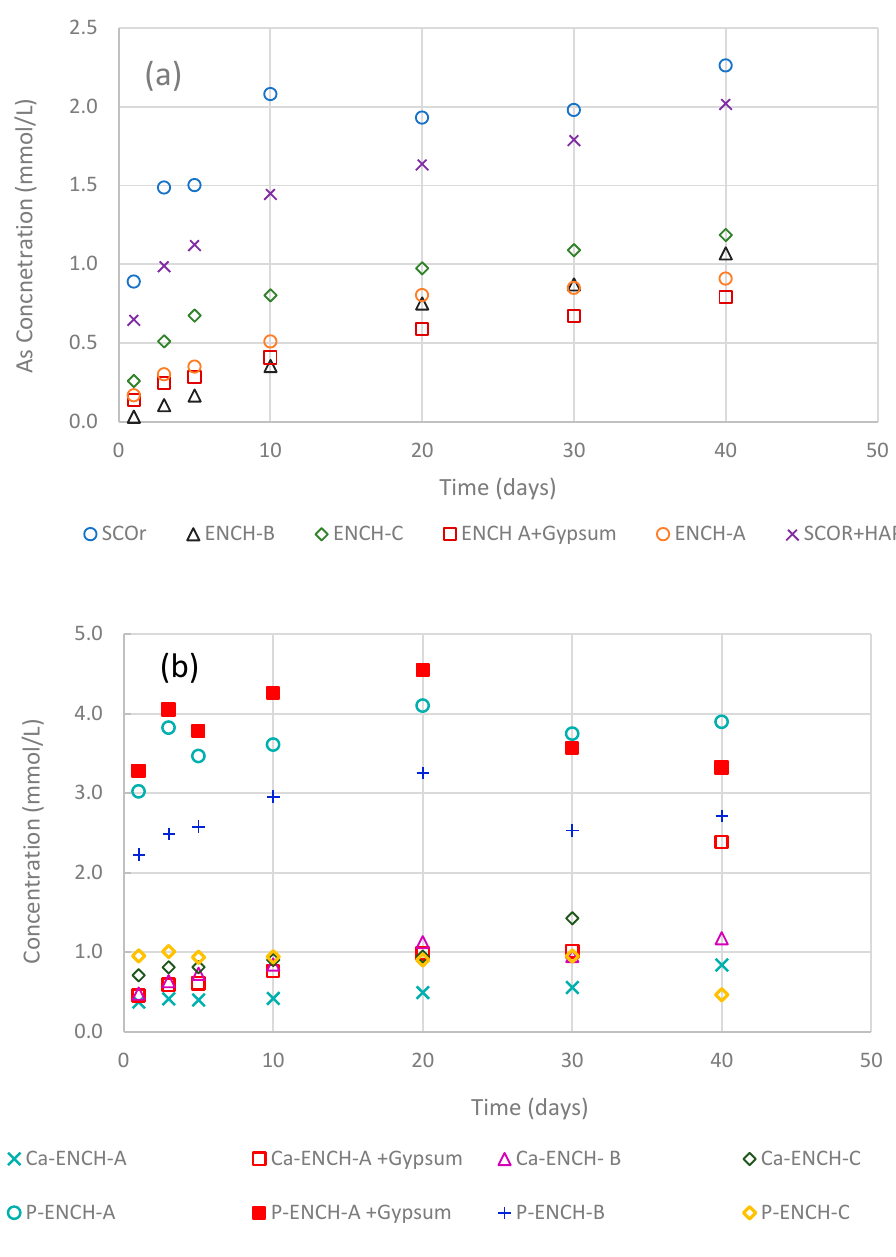
Figure 9. Arsenic release ( a ) and Ca and P ( b ) under anoxic conditions (pH 8; 150 mV) from various HAP-coated and naked scorodite materials, gypsum-free and gypsum-containing waters.